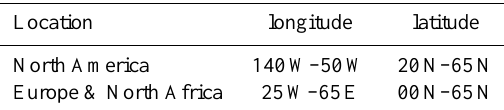
Table 2. Geographic